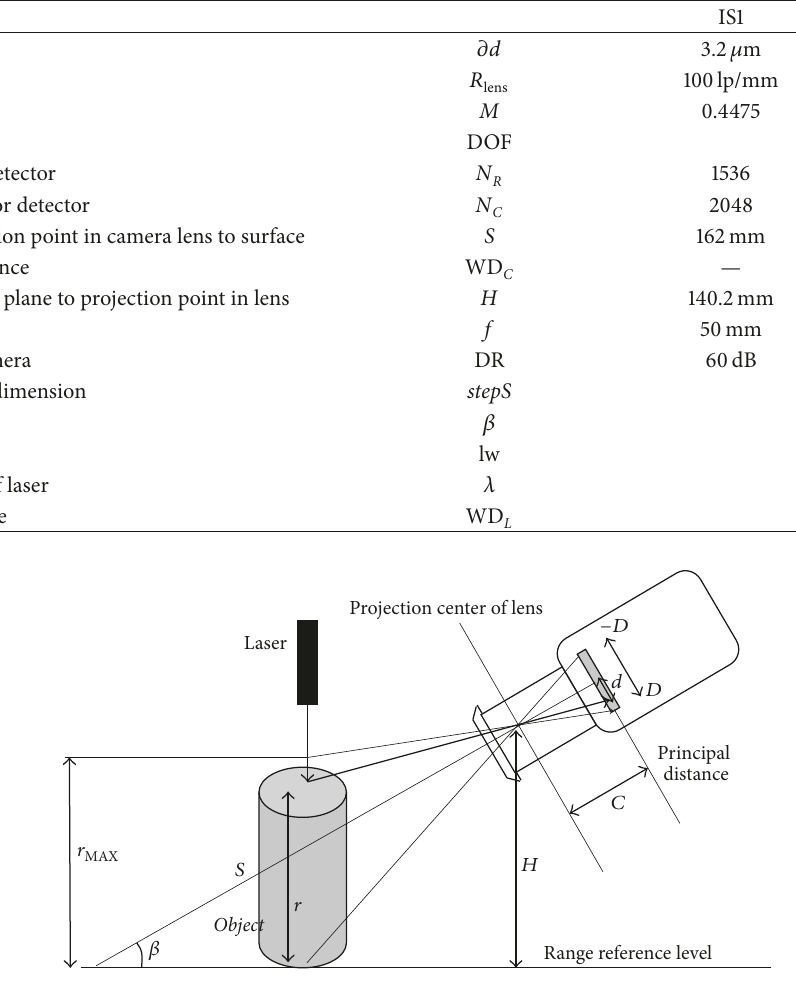
Figure 2: Geometry of laser